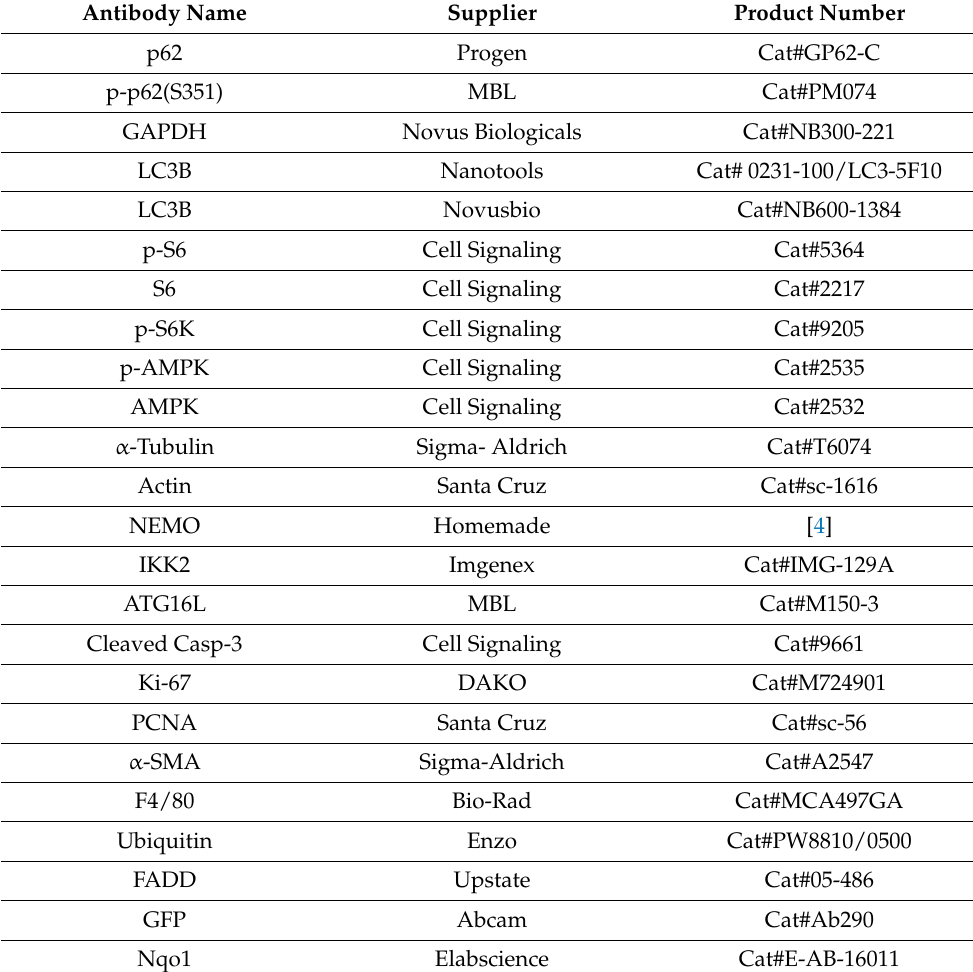
Table 1. The antibodies used for immunoblotting and immunostaining procedures, together with their supplier and product